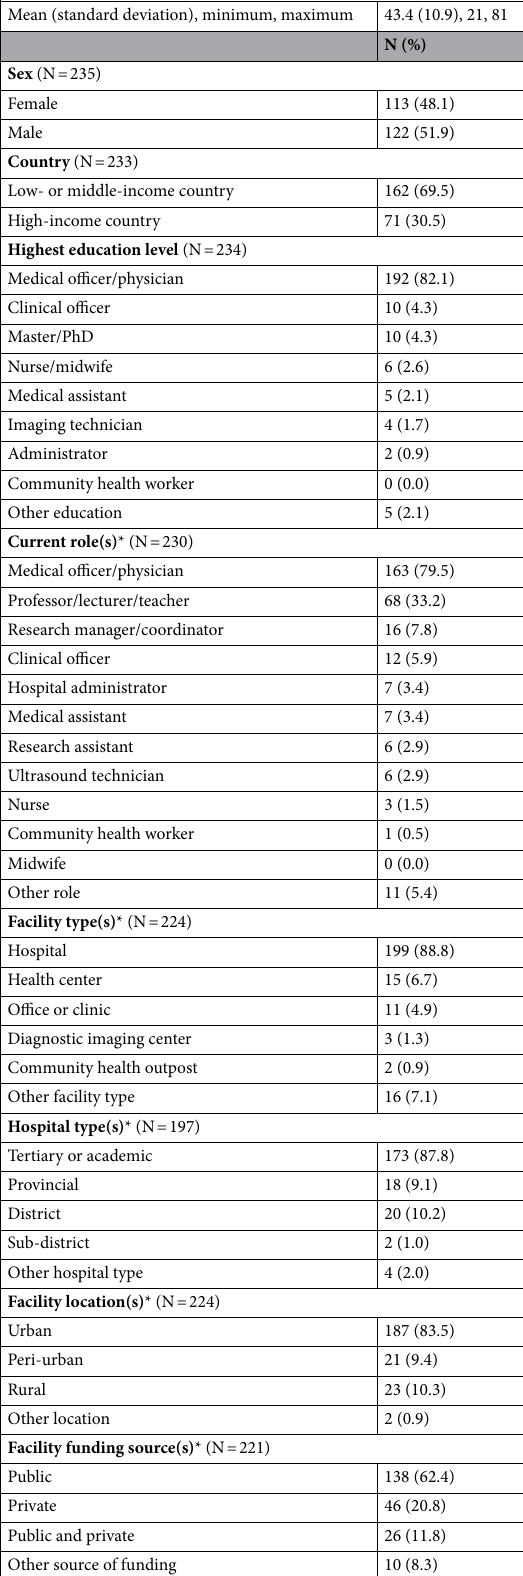
Table 1. Survey respondent and facility characteristics. *Total percentage for individual question may be over 100% due to “Check all that apply” option for that question on the survey. The value for N provided for “Check all that apply” questions represents the number of